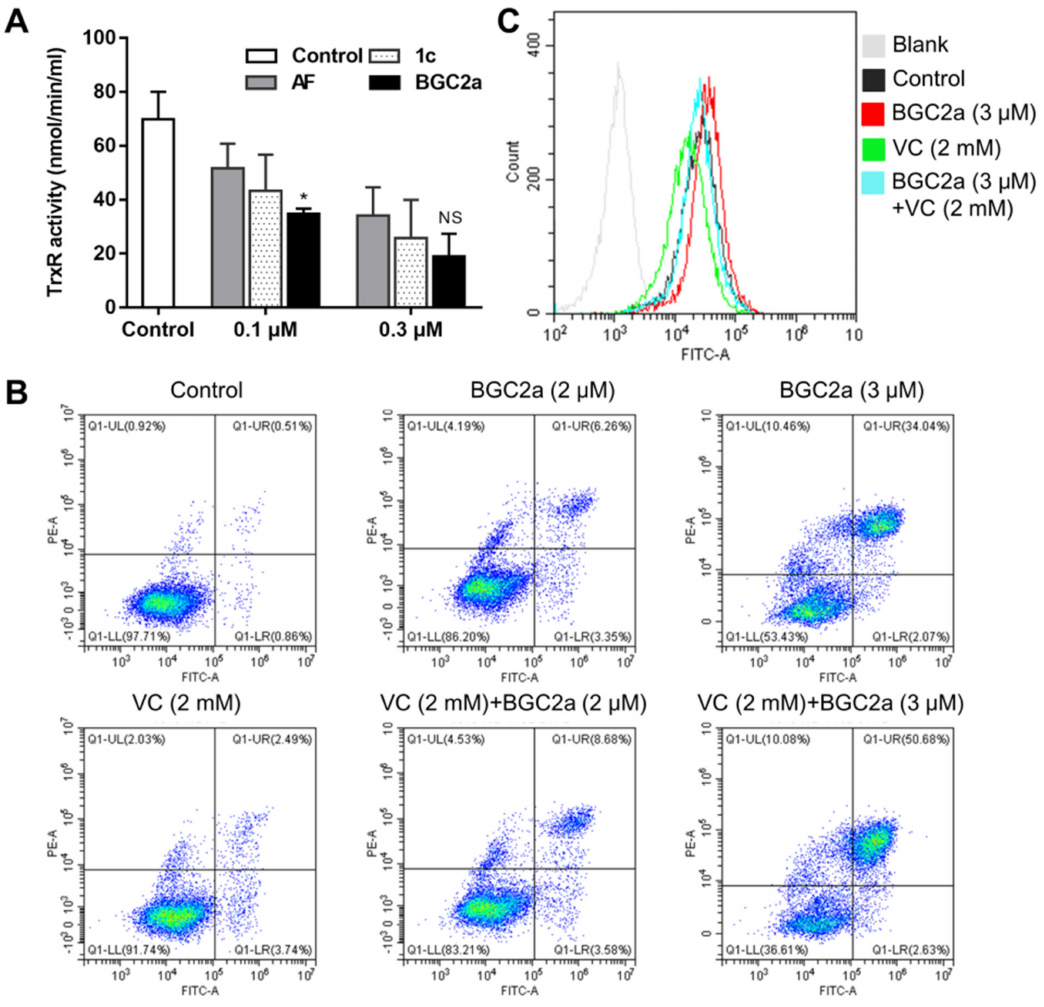
Figure 2. The effects of AF and BGC2a on cellular TrxR, ROS, and apoptosis induction in A549 cells. ( A ) After treatment by AF and BGC2a at 0.1 and 0.3 µ M for 2 h, cellular TrxR enzymatic activity was measured by TrxR Activity Colorimetric Assay Kit. (*) p < 0.05. ( B ) The induced apoptosis